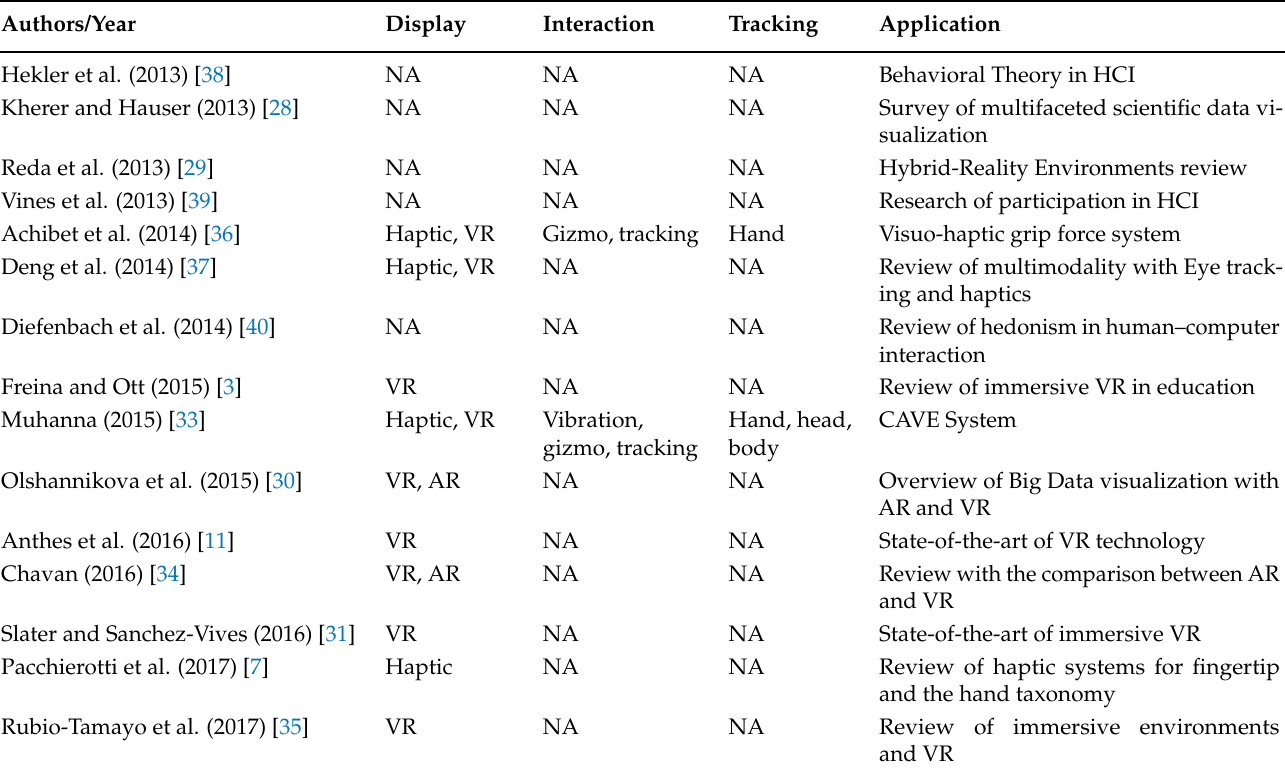
Table 2. Data table of the concepts and overviews